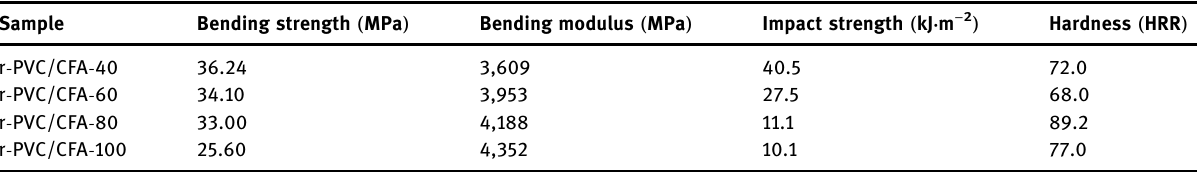
Table 4: Mechanical properties of r - PVC/CFA composites